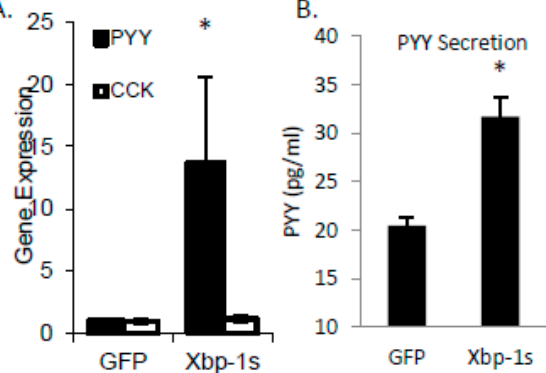
Figure 3. Lipid-mediated regulation of PYY gene expression through Xbp1s. ( A ) Using pre-formed